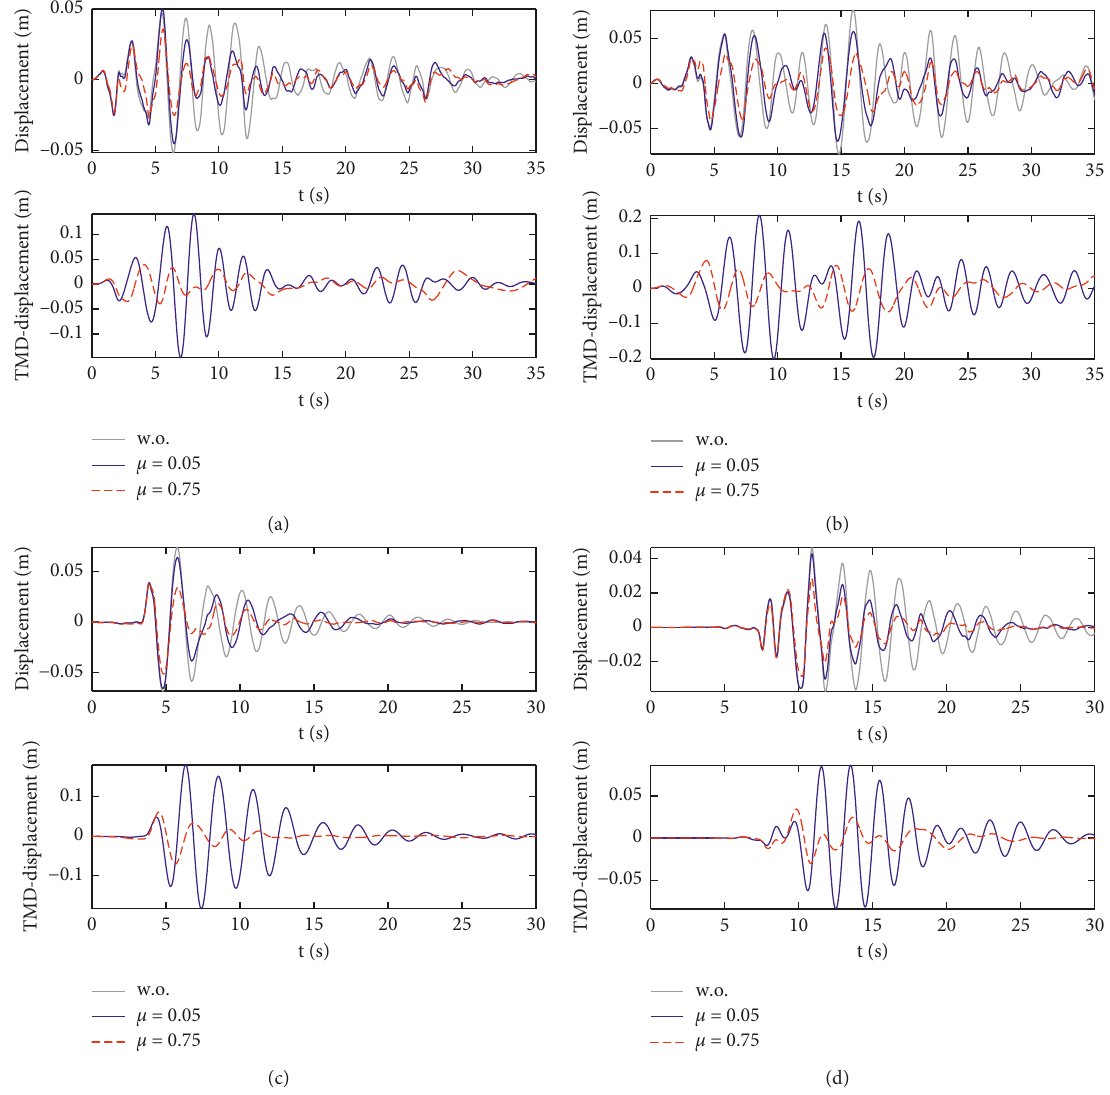
Figure 15: The damping effect of different mass ratio TMDs on the displacement-time history of the main structure ( T relative displacement-time history between the TMD and the structure (w.o. denotes the displacement of a structure without a TMD). (a) El Centro. (b) Hachinohe. (c) Northridge. (d)